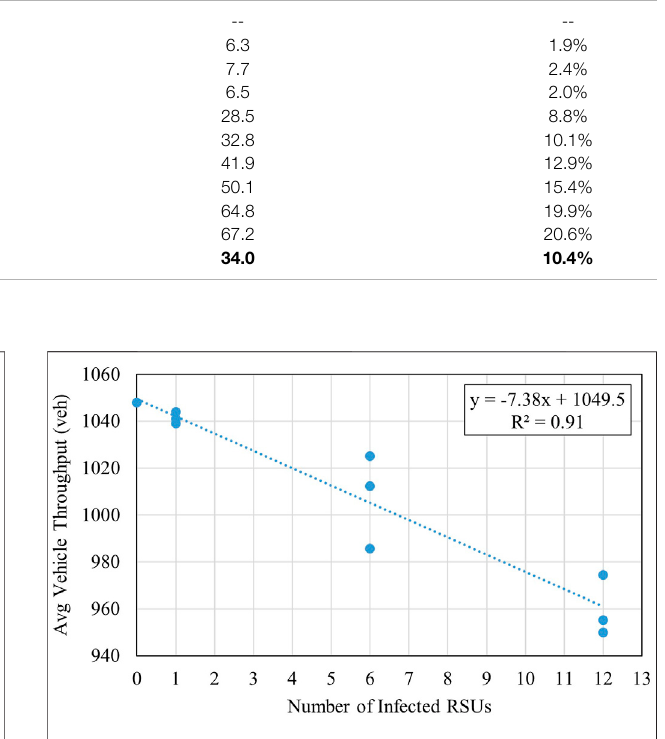
FIGURE 1 | DoS Infected RSUs vs Travel Time. FIGURE 2 | Infected RSUs ’ impact on average throughput —